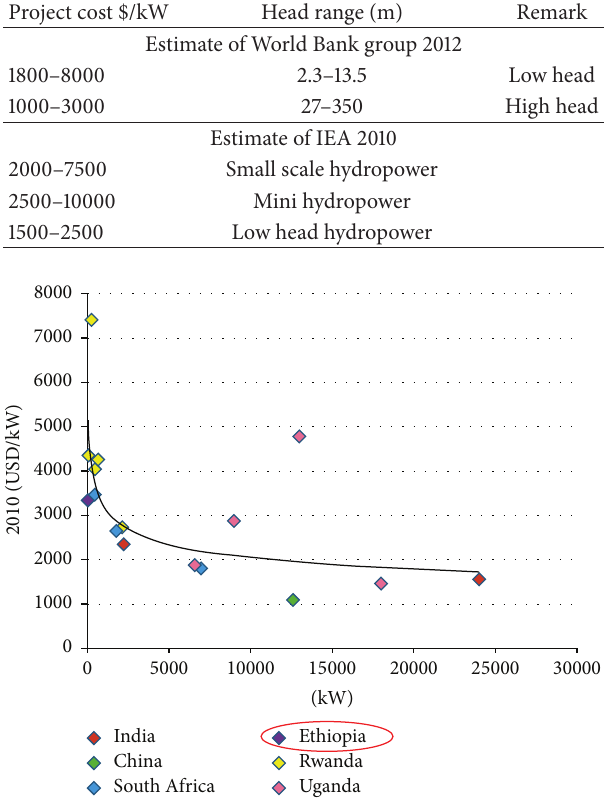
Figure 3: Installed capital costs for small hydro in developing countries by capacity [39].